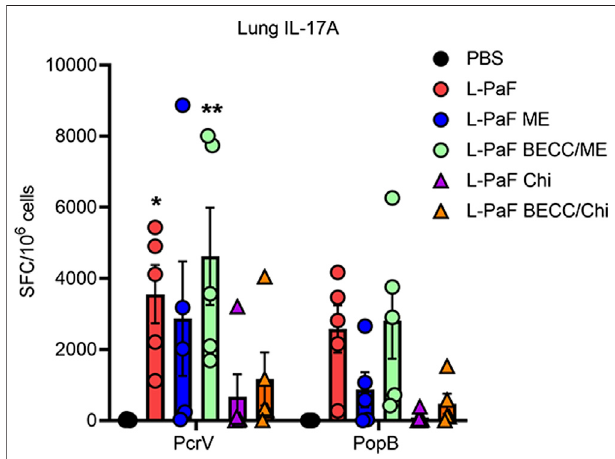
FIGURE5| Lungcells secretes IL-17Afollowingantigen-speci fi c exvivo stimulation. Lung cell suspensions were prepared as described in the text. They were treated with 5 μ g/ml of either PcrV or PopB and incubated for 24 h at 37 ° C. IL-17A secreting cells were enumerated by ELISpot and were plotted as Spots Forming Cells (SFC)/10 6 cells. Data were plotted as actual values from individuals ± SD (n (cid:2) 5) in each group. Statistical signi fi cance was calculated by comparing the PBS group with their immunized counterparts using two-way ANOVA (Dunnett ’ s multiple comparison test). * p < 0.05, ** p < 0.01.